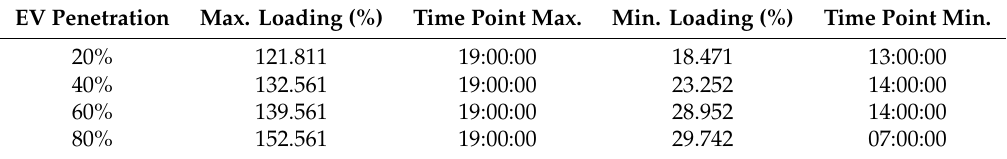
Table 1. Urban transformer loading data.